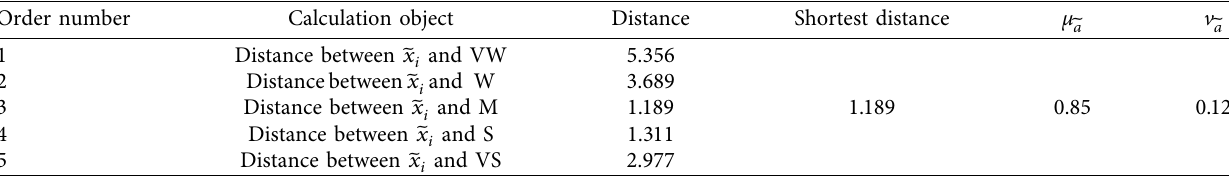
i and the 5 language variables in Table 2.